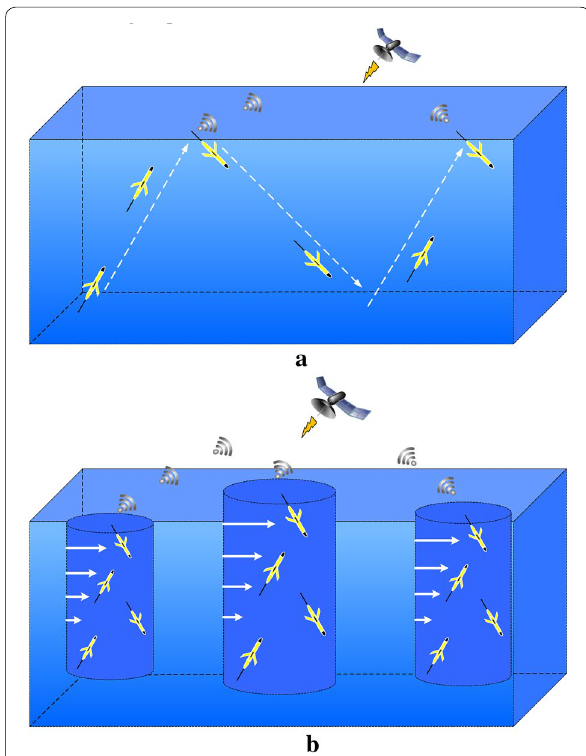
Figure 6 The operational modes of gliders: ( a ) sustained occupations of sections (sawtooth-shaped gliding); ( b ) station-keeping (virtual